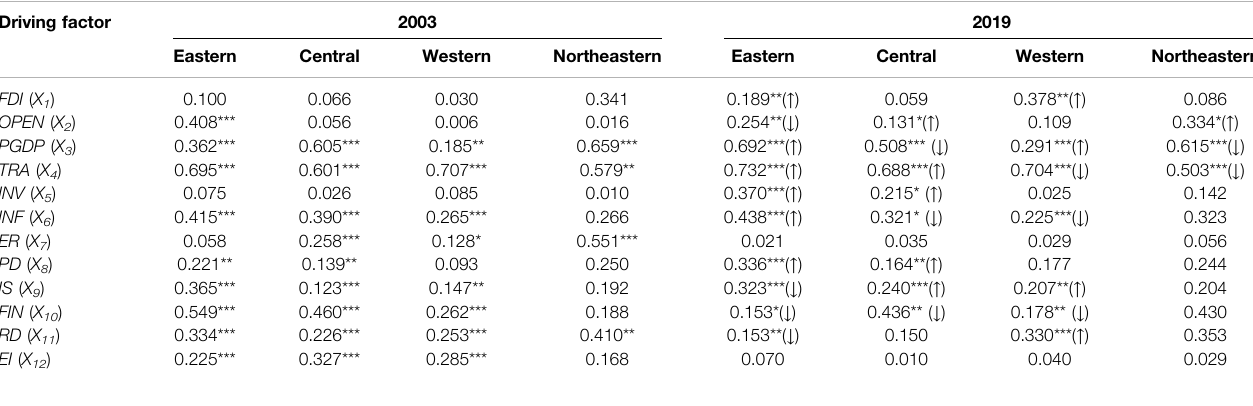
TABLE 4 | PD values for driving factors in four regions of China (2003 and